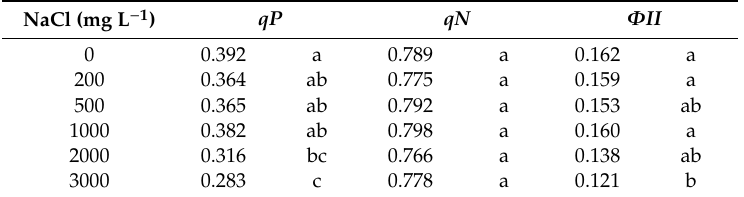
Table 1. Effects of NaCl levels in irrigation water on chlorophyll fluorescence parameters in Exp. 1.